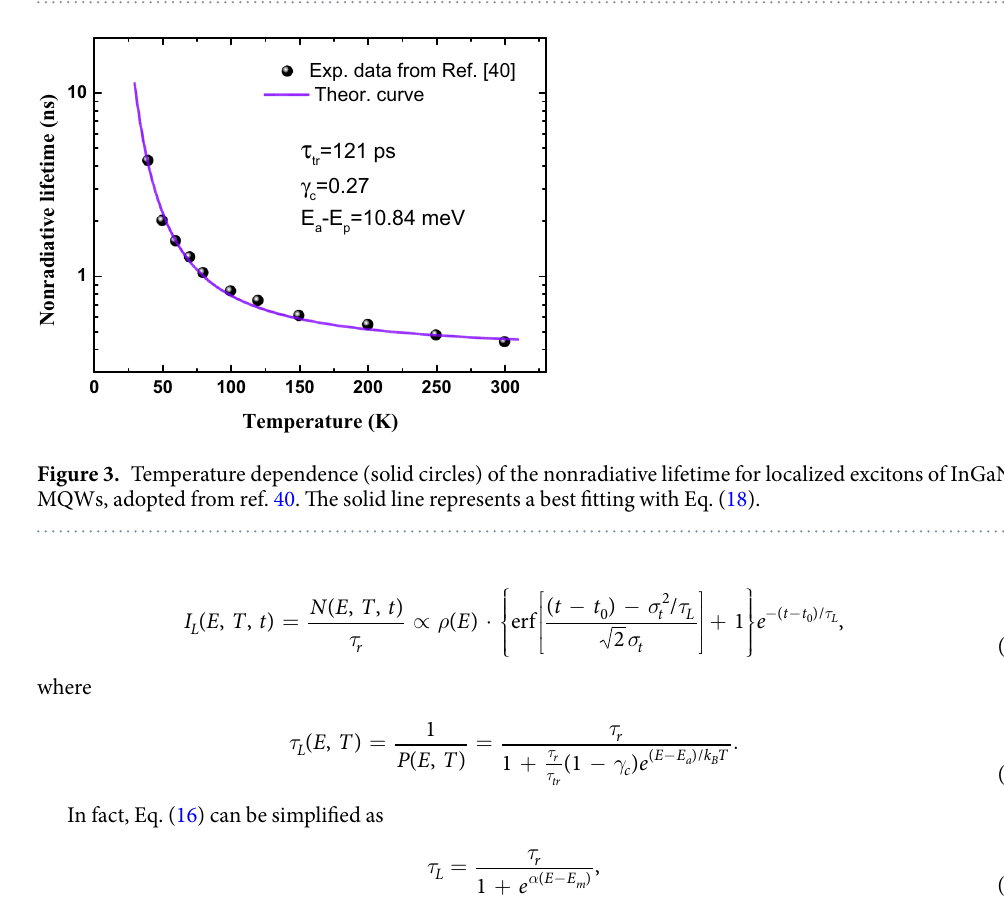
Figure 2. Calculated TRPL spectra (image) of a localized state system with Eq. (15). Obviously, the theoretical luminescence lifetime shows a distinct dependence on energy (right figure), while luminescence spectrum exhibits an interesting dependence on the delay time (top figure).